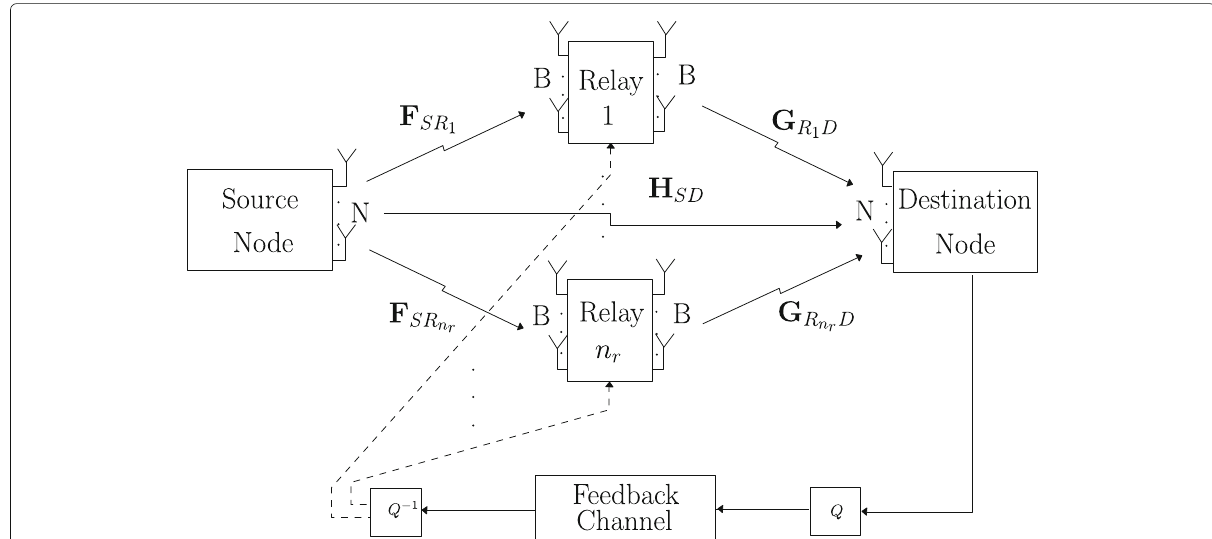
Fig. 1 Cooperative MIMO system model with multiple-antenna n r relay